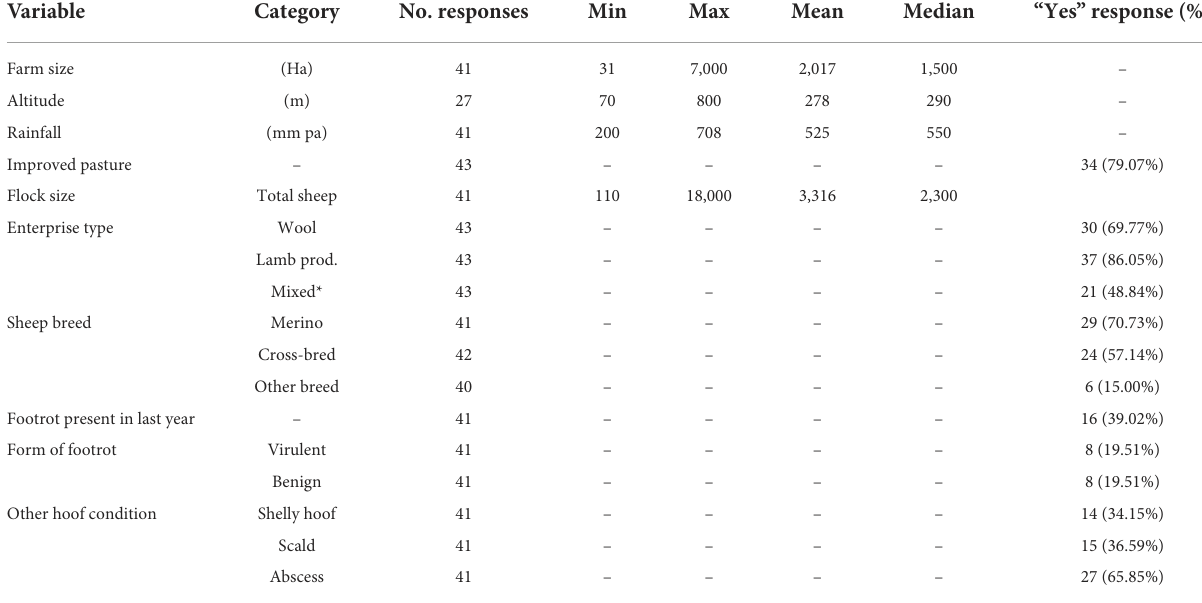
Form of footrot